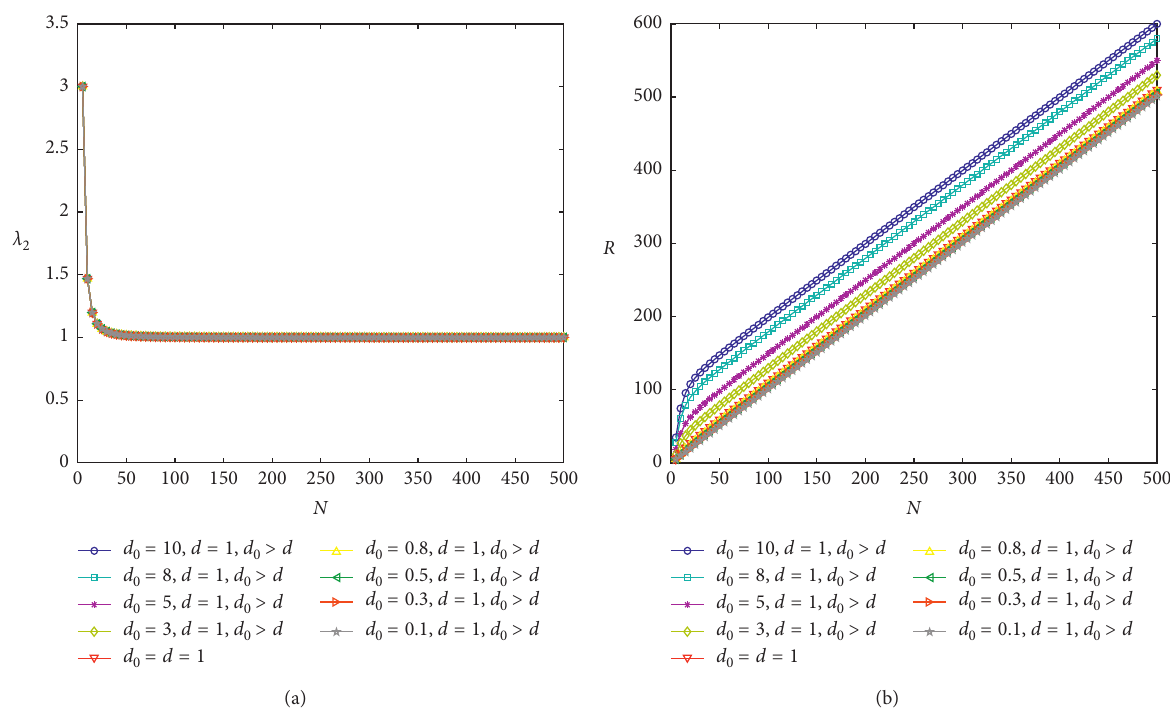
Figure 9: The synchronizability of multilayer star-ring networks vs . varying the number of nodes N ( a � 1, M � 10, d � 1, and a < Md ). (a) λ with respect to varying N for different d 0 . (b) R with respect to varying N for different d 0